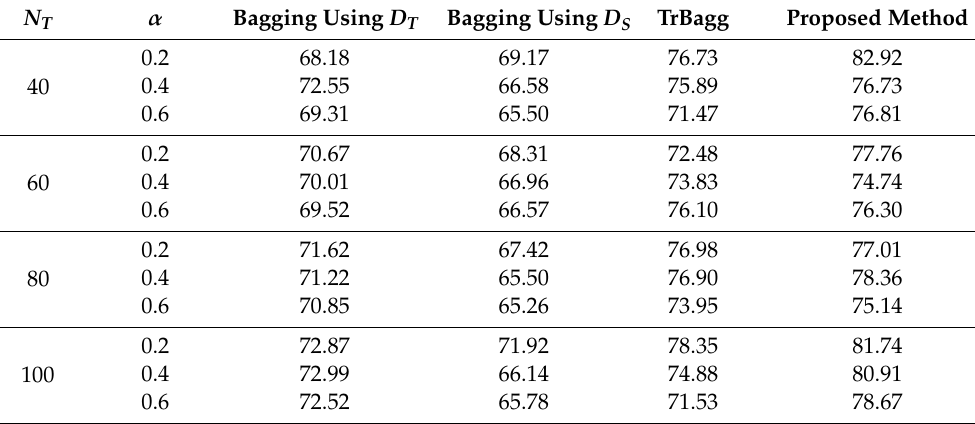
Table 3. Accuracy of test data using the abalone dataset.